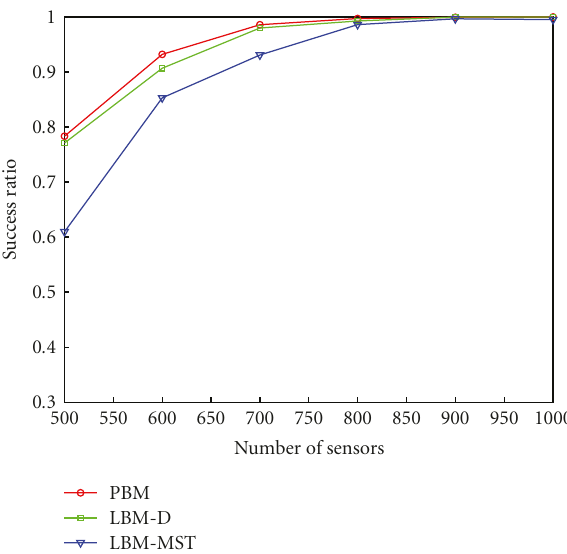
Figure 8: Success rates for separately distributed destinations.